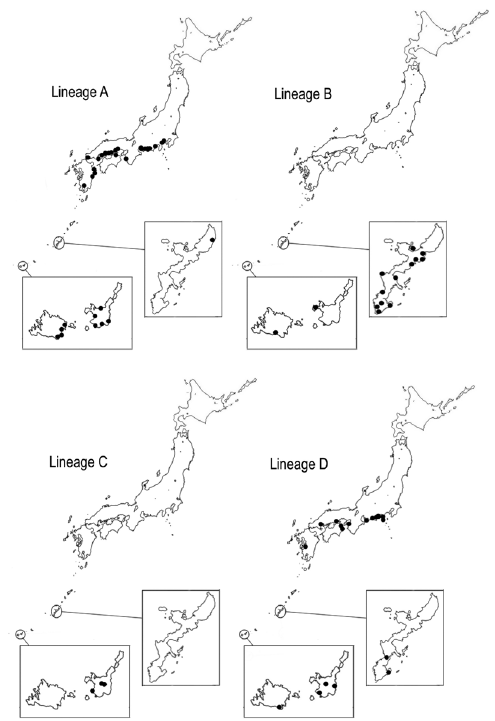
Fig 4. Distribution map of Cardiocondyla sl. kagutsuchi lineages A, B, C and D in